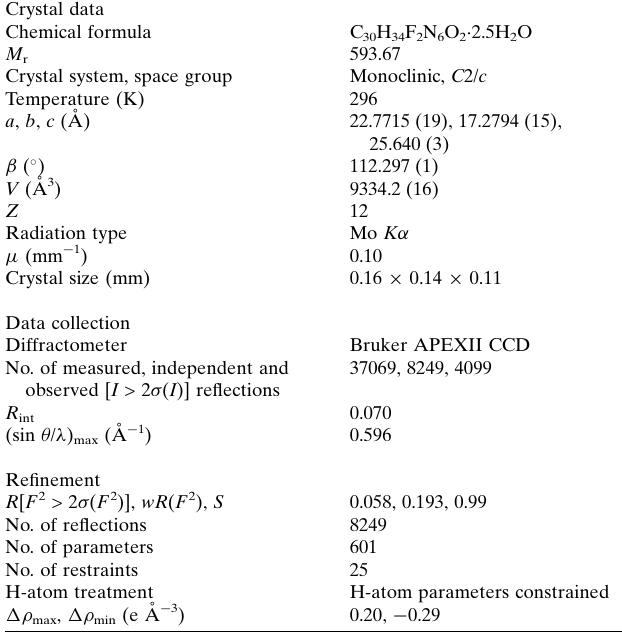
Crystal data Chemical